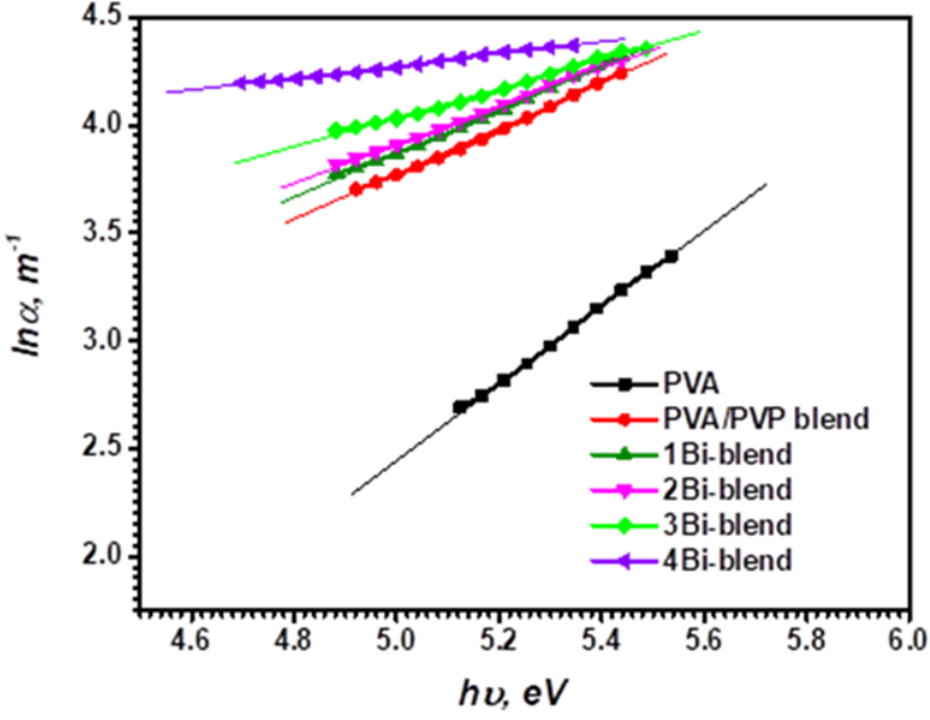
Figure 7. Variation of ln α versus the photon energy ( h ν ) of pristine PVA, PVP/PVA blend, and Bi-blend hybrid films.